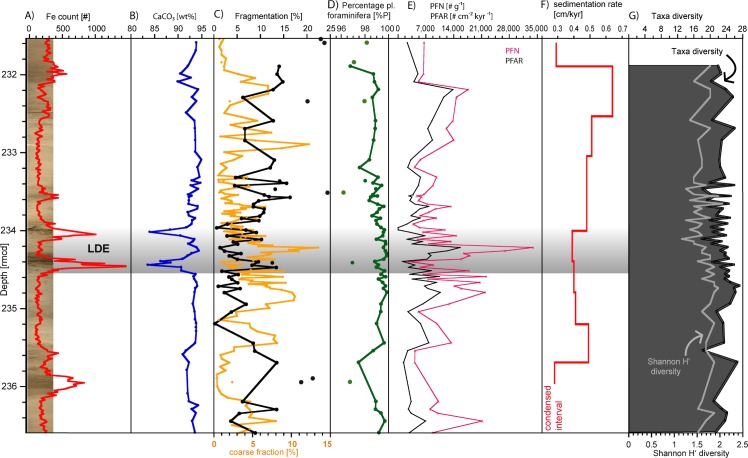
Sedimentary and other parameters of Site 1210.The LDE is marked in grey, data available in S4 Table. A) Biostratigraphy and Fe XRF core scanning data overlying the sediment core photo. The two main peaks mark the LDE and are used for stratigraphic correlation. The LDE interval covering the XRF Fe peaks are marked by a blue bar. The misfit between XRF core scanning Fe peaks and lithology is most likely an artifact of core expansion in storage. B) CaCO3 data. C) Coarse fraction (orange) and fragmentation (black) show opposing trends. D) Percentage of planktic foraminifera [%P] (green) shows only little variation below 100% with minima close to Fe maxima. For C) and D): Data points marked as single symbols represent samples that have been excluded from faunal assemblage analyses due to potential diagenetic alteration. E) The amount of planktic foraminifera per g sediment (PFN [# g-1], pink) has a minimum close to the first LDE peak and a maximum shortly thereafter, however, the variability of planktic foraminiferal accumulation rates (PFAR, black, [# cm-2 kyr-1]) is much lower than the absolute abundance of planktic foraminifera per gram sediment. F) Sedimentation rate according to [24] based on the presented cyclostratigraphy therein. G) Simple diversity (grey) and Shannon H’ diversity (black line with a dark grayish background) both indicate a slight decrease during the LDE interval.